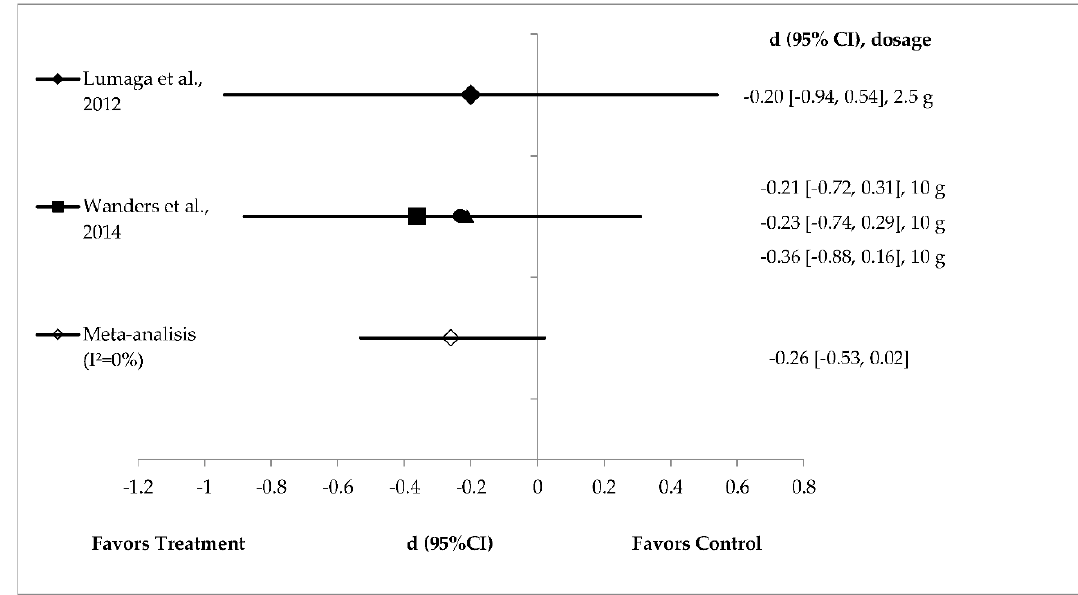
Figure 6. Effects of pectin on energy intake reduction (fixed effects model). The axis lines on ±0.2, ±0.5 and ±0.8 represent small, medium and large effect sizes respectively. A negative value of summary effect size suggests that pectin supplementation decreases energy intake compared to control. d = effect size; CI = confidence interval. (cid:78) : bulking; (cid:4) : gelled; : viscous.